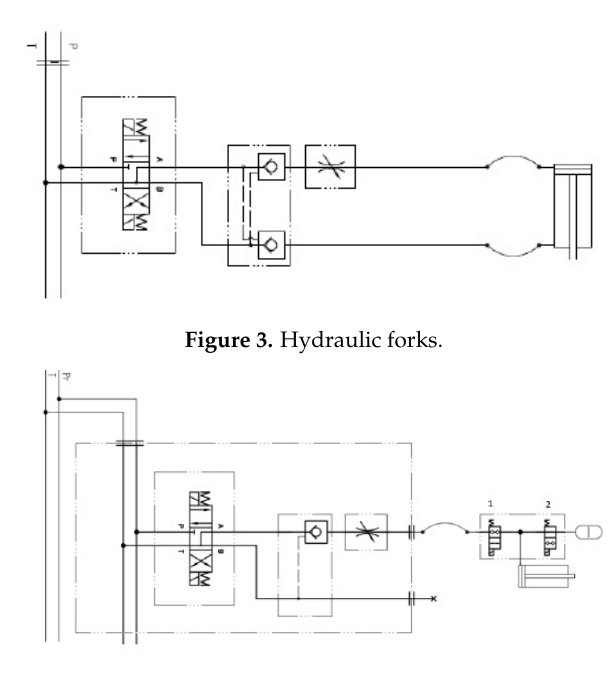
Figure 4. Hydraulic suspensions.